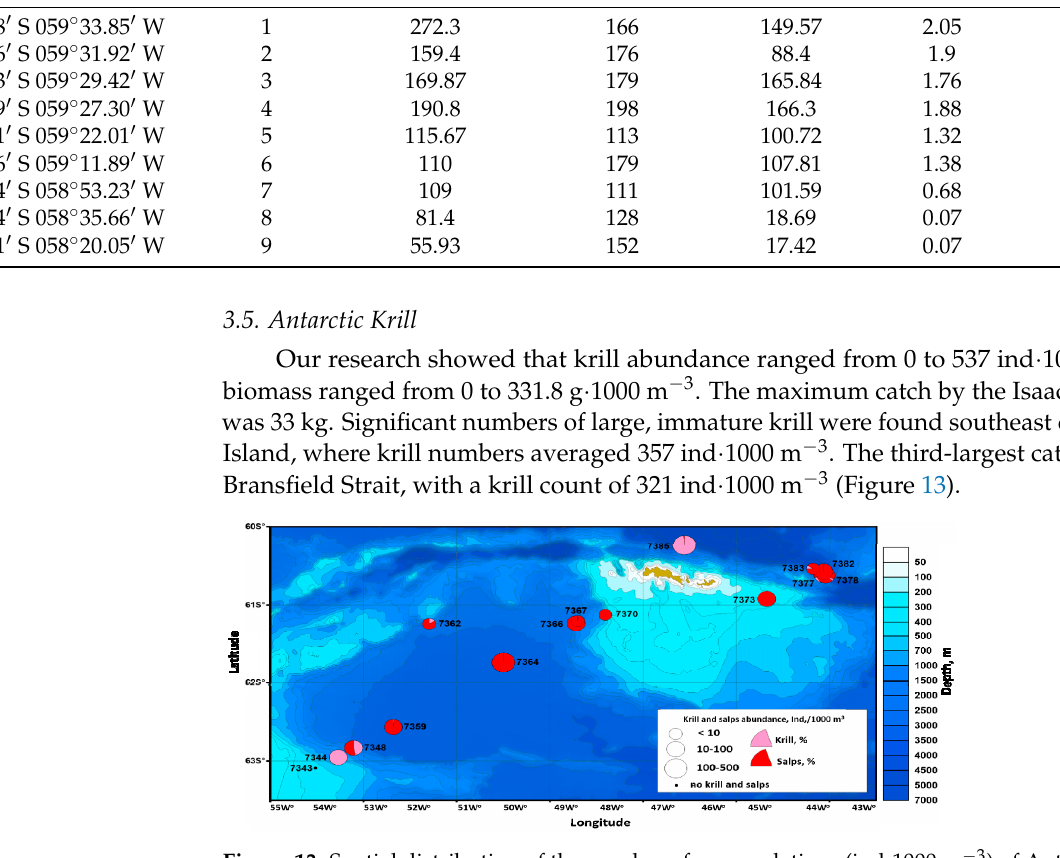
Figure 13. Spatial distribution of the number of accumulations (ind · 1000 m − 3 ) of Antarctic krill and salps (%) in the Powell Basin and the area of the South Orkney Islands, according to results from the 87th cruise of R/V “Akademik Mstislav Keldysh” in 2022. The bulk of the catch consisted of juvenile fish.